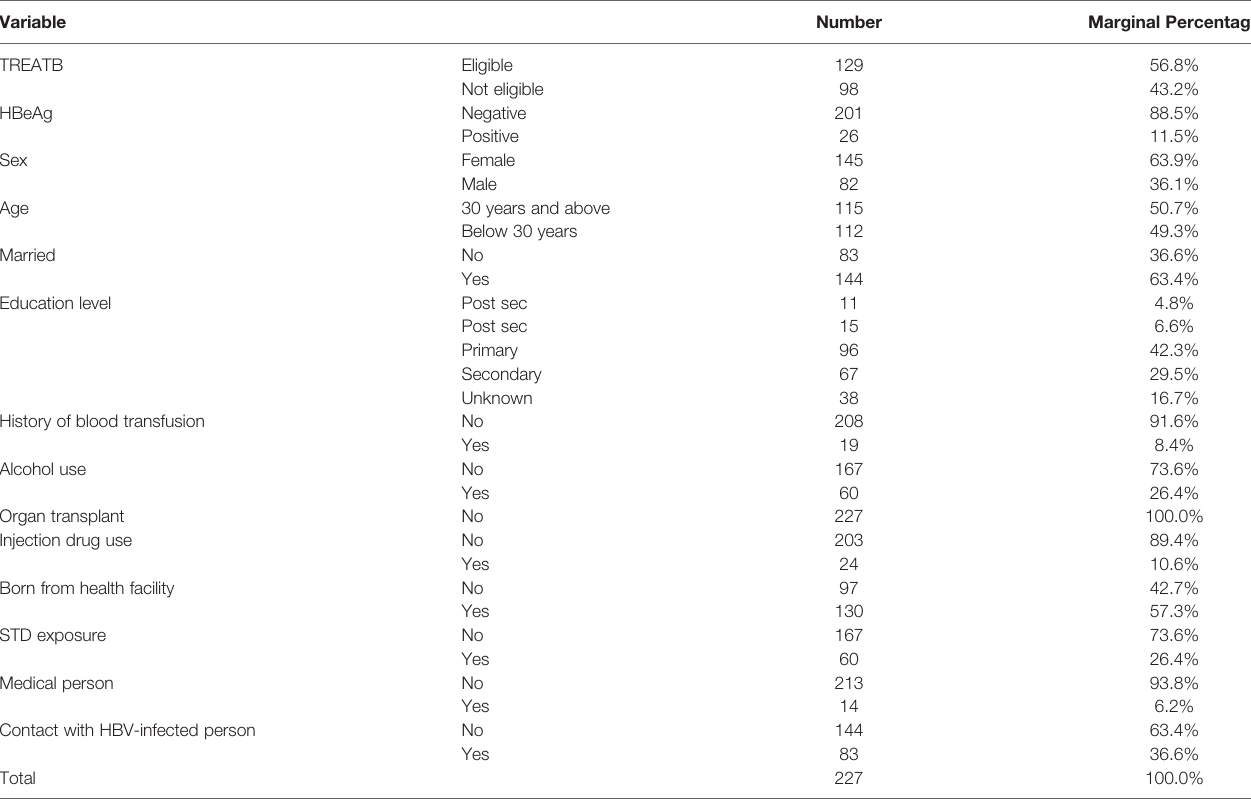
TABLE 1 | Socio-demographic characteristics of our study